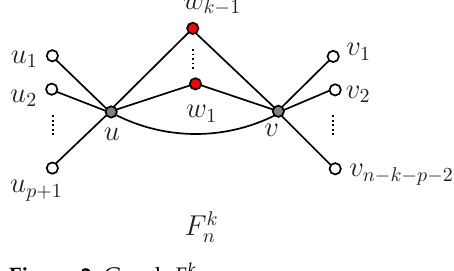
Figure 2. Graph F k n